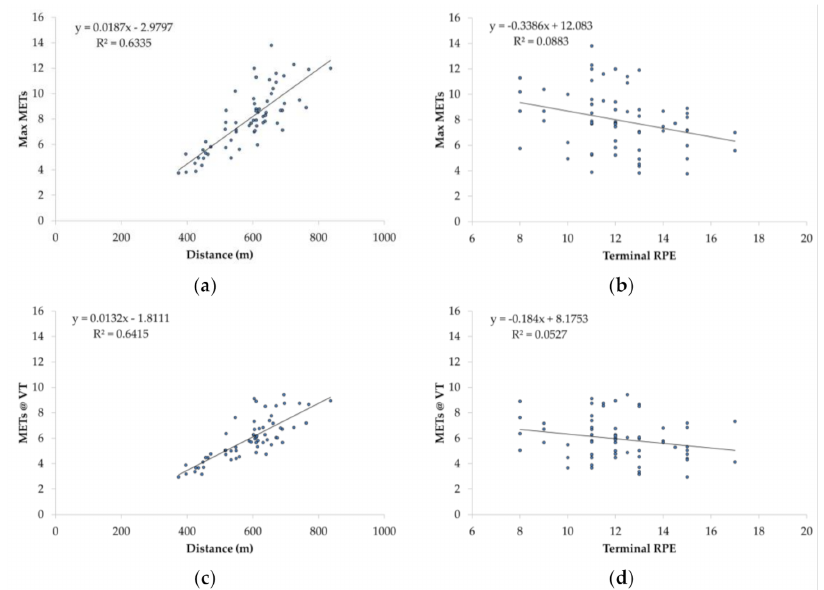
Figure 1. Bivariate relationship between the 6-min walk test (6MWT) distance and the maximal Metabolic Equivalents (Max METs, ( a )), the terminal rating of perceived exertion (RPE) and Max METs ( b ), the 6MWT distance and Metabolic Equivalents at the ventilatory threshold (METs@VT, ( c )) and the terminal RPE and METs@VT ( d ).